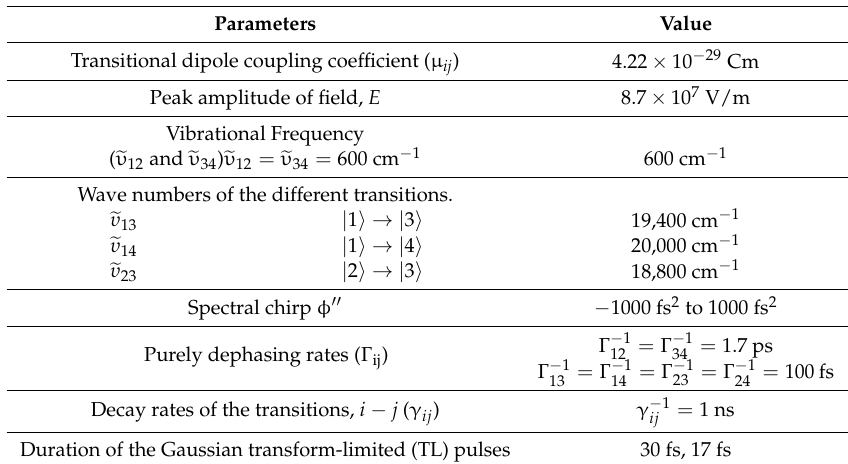
Table 1. Parameters used in the